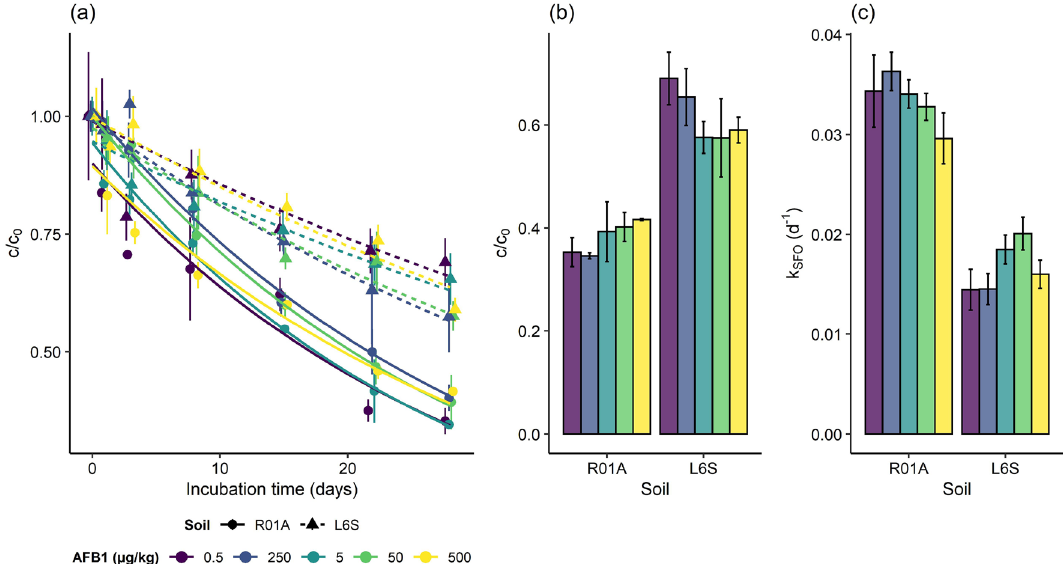
Figure 2. AFB1 dissipation for the sandy loam soil (“R01A”) and clay soil (“L6S”) amended with 0.5, 5, 50, − 1 250 and 500 µ gkg AFB1 and incubated under nonsterile (MD) conditions. Curves showing single first order kinetic model fitted to data ( a ), normalized AFB1 concentration c/c 0 at the end of 28-days incubation ( b ) and single first order dissipation rate constants ( c